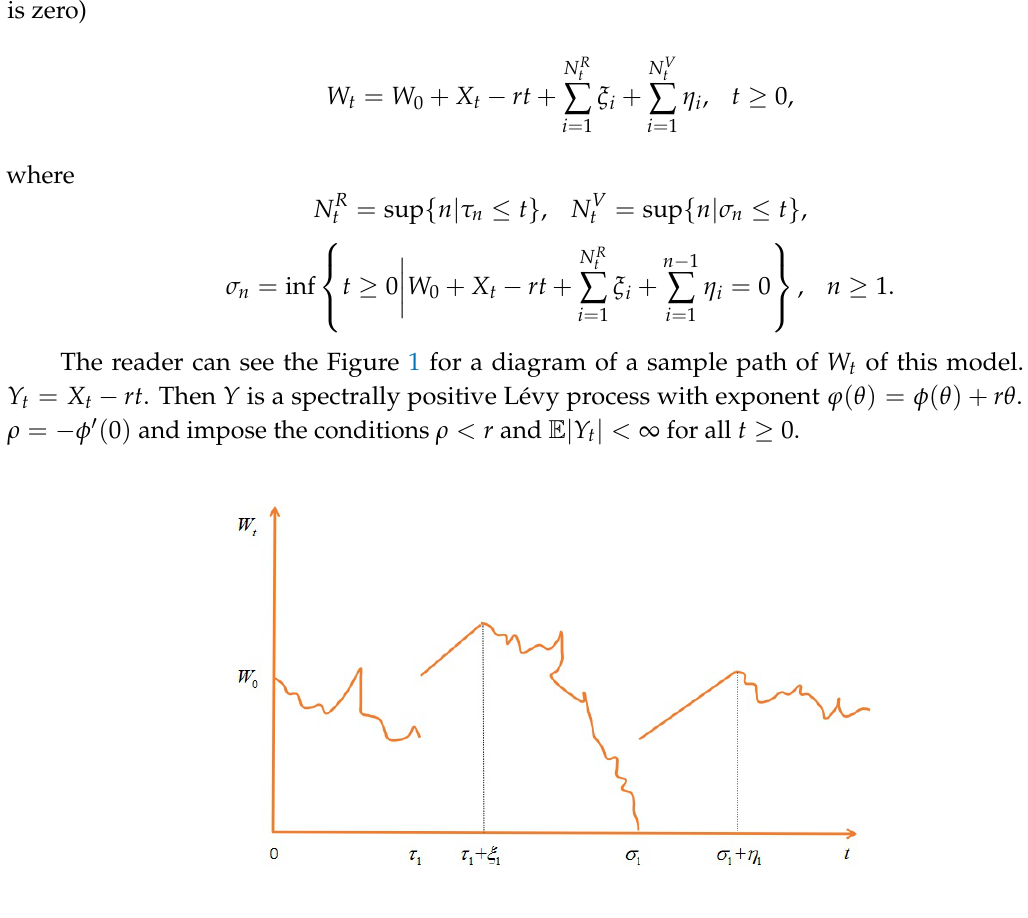
Figure 1. A diagram of a sample path of W t